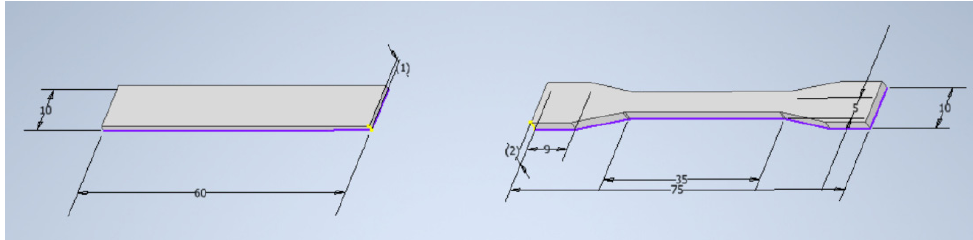
( b ) Figure 3. Samples obtained by the method of: ( a ) 3D printing; ( b ) injection molding. The process parameters are summarized in Tables 2 and 3. Table 2. Selected printing parameters. Nozzle diameter